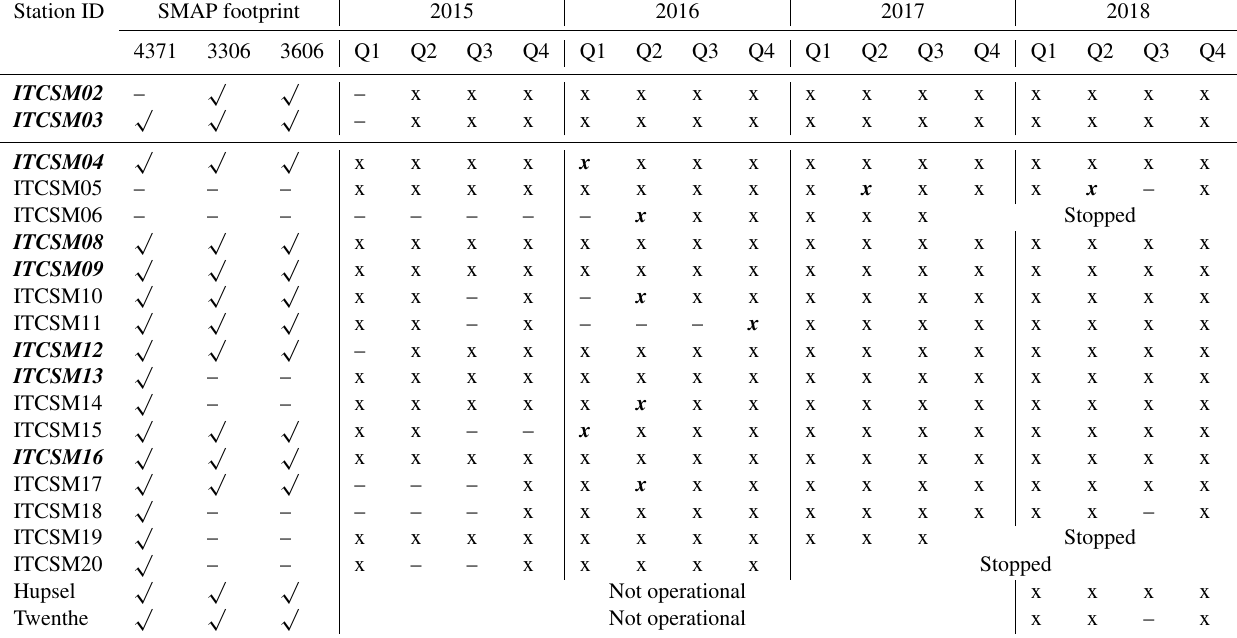
Table 1. Data availability of the Twente monitoring stations within SMAP footprints. Q1, Q2, Q3, and Q4 refer to quartiles 1 (January– for the SMAP footprint, “ x ” indicates that the data are available for that specific period and station, and “–‘’ means that the two previous qualifications are not applicable. Bold and italic “x” suggests that the location of the station was changed; exact dates are given in Table S1. Bold and italic station IDs highlight that records over the period 2015–2018 are fairly